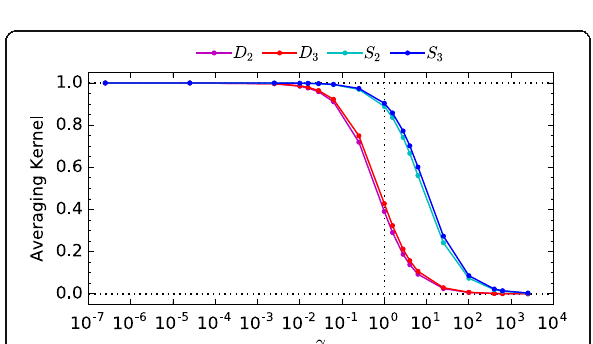
Fig. 13 Relation between regularization parameter ( γ w ) of TCWV and diagonal elements of AKM